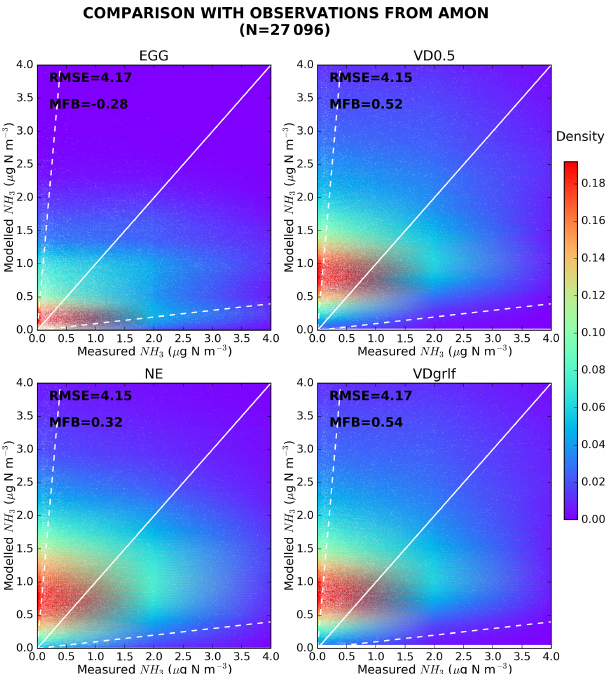
Figure 6. Validation of modelled concentrations of ammonia for different emissions datasets (EGG, VD0.5, NE and VDgrlf) against ground-based measurements from AMON for the 10-year (2008– 2017) study period. Scatterplots of modelled against measured con- centrations for the aforementioned emission inventories were plot- ted with the Kernel density estimation, which is a way to estimate the probability density function (PDF) of a random variable in a non-parametric